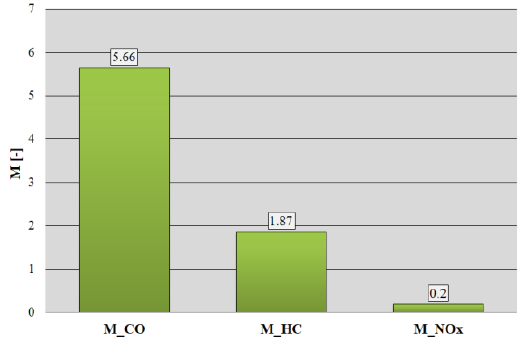
Fig. 10. Summary of M toxicity indicators for CO, HC, and NO x when tested in the WMTC